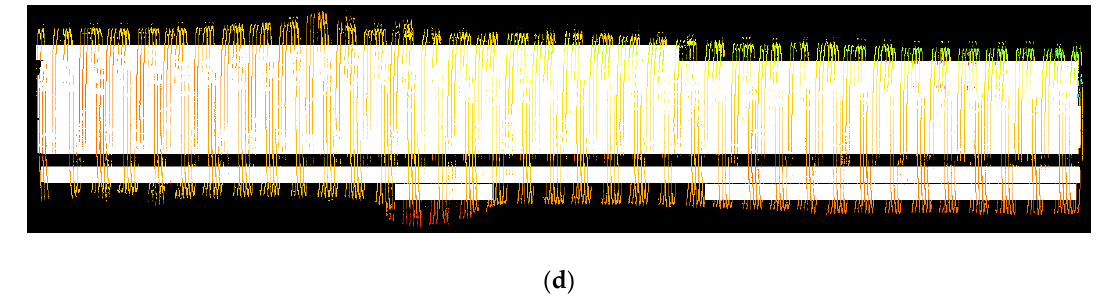
Figure 17. Sample log with the products fitted to the side parts of the log formed after cutting out the square cant. Simplified geometry of the log is drawn in colors ranging from green to red, depending on distance to the center axis of the log. Products are marked in white; ( a , b ): frontal views; ( c , d ): side views of the log .